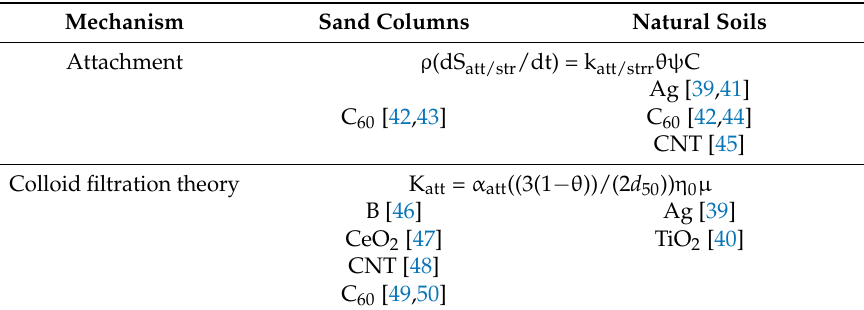
Table 1. Equations (examples) used for transport modelling of different NMs in sand columns or stacked columns of natural